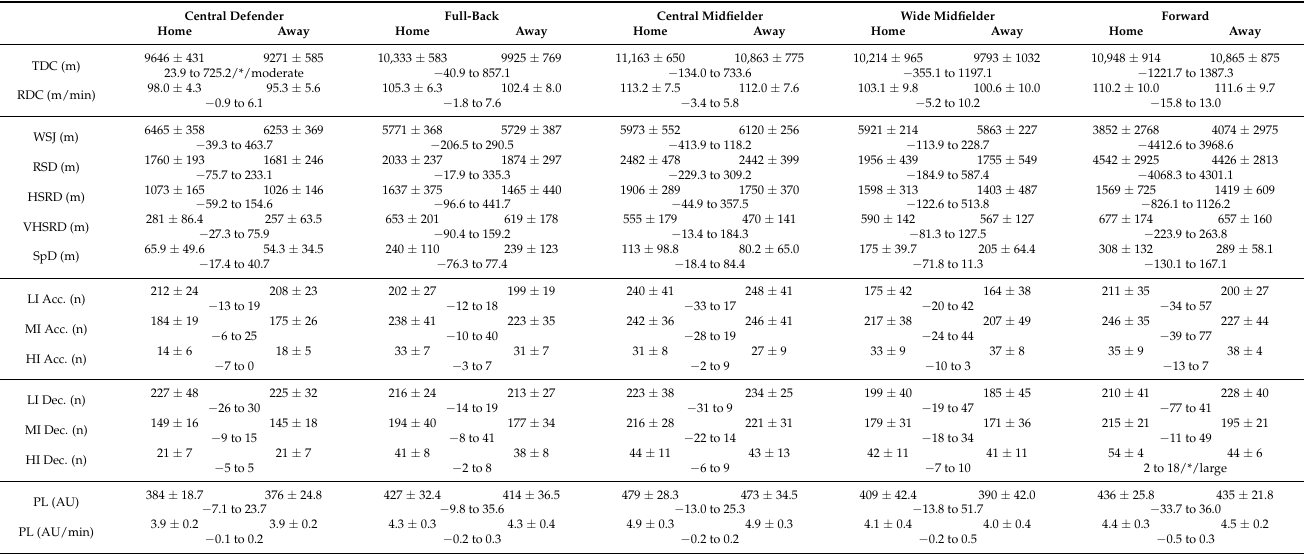
Table 3. External match load—comparison between match location (home/away), mean ± SD, CI 95%, and ES.